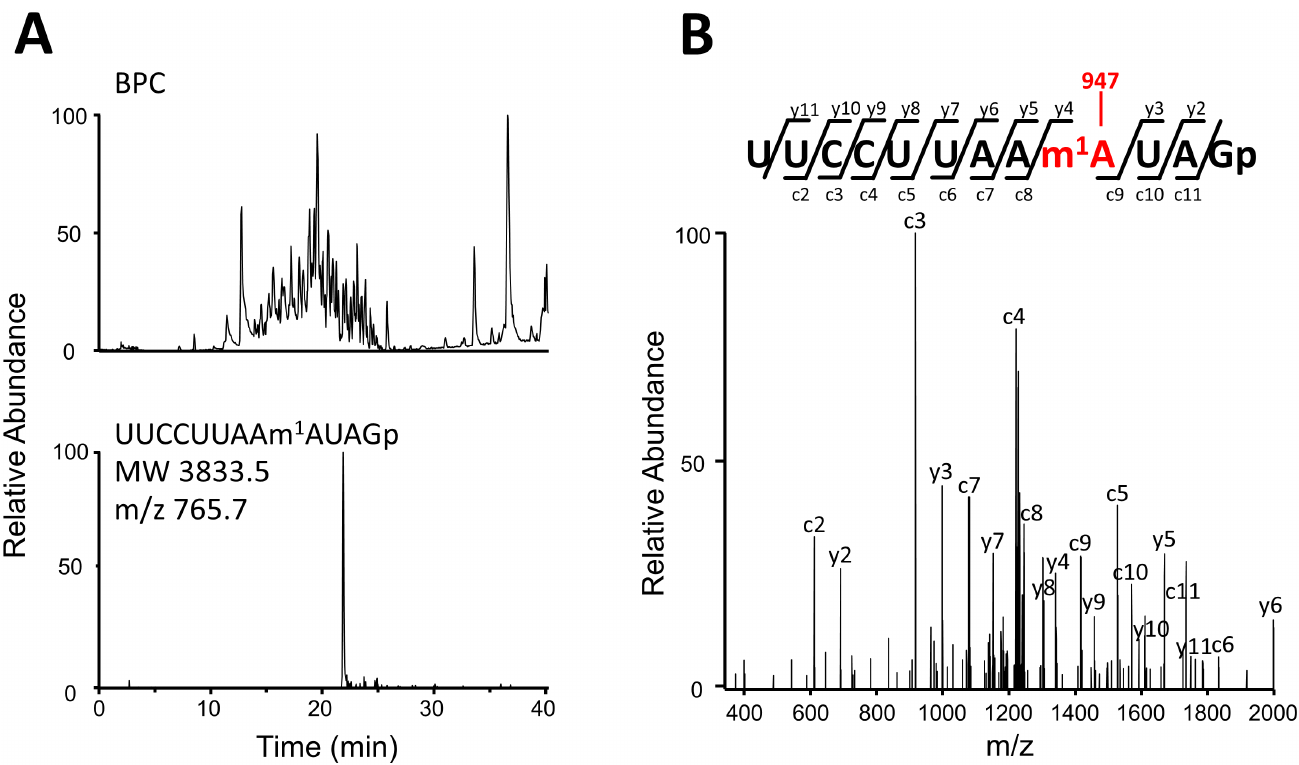
Fig 1. Human mitochondrial 16S rRNA is methylated at position 947. ( A ) Capillary LC/ESI-MS analysis of RNA fragments of human mitochondrial 16S rRNA digested with RNase T 1 . The upper panel shows a base-peak chromatogram (BPC), and the lower panel represents mass chromatogram for detecting quintuple (-5)-charged ion of the methylated 12-mer fragment (UUCCUUAAm 1 AUAGp, m/z 765.7). ( B ) Collison-induced dissociation spectrum of the methylated 12-mer fragment. The sequence was confirmed by assignment of the product ions. Nomenclature for the product ions is in accordance with a previous report